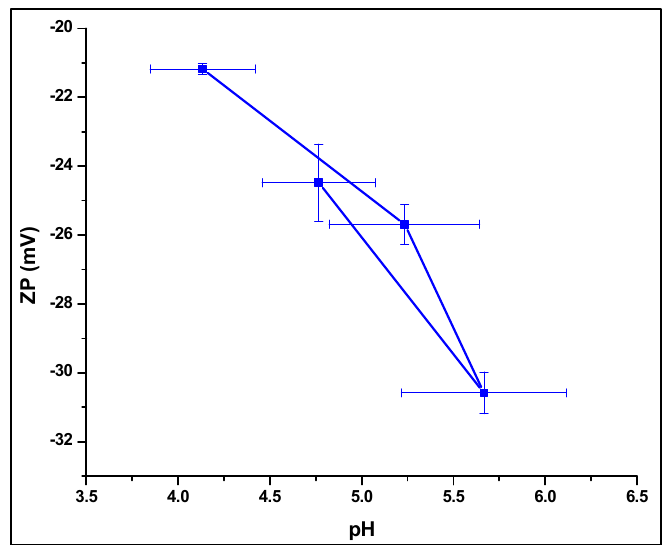
Figure 4. Correlation between LRX-NE formulation pH and zeta potential.